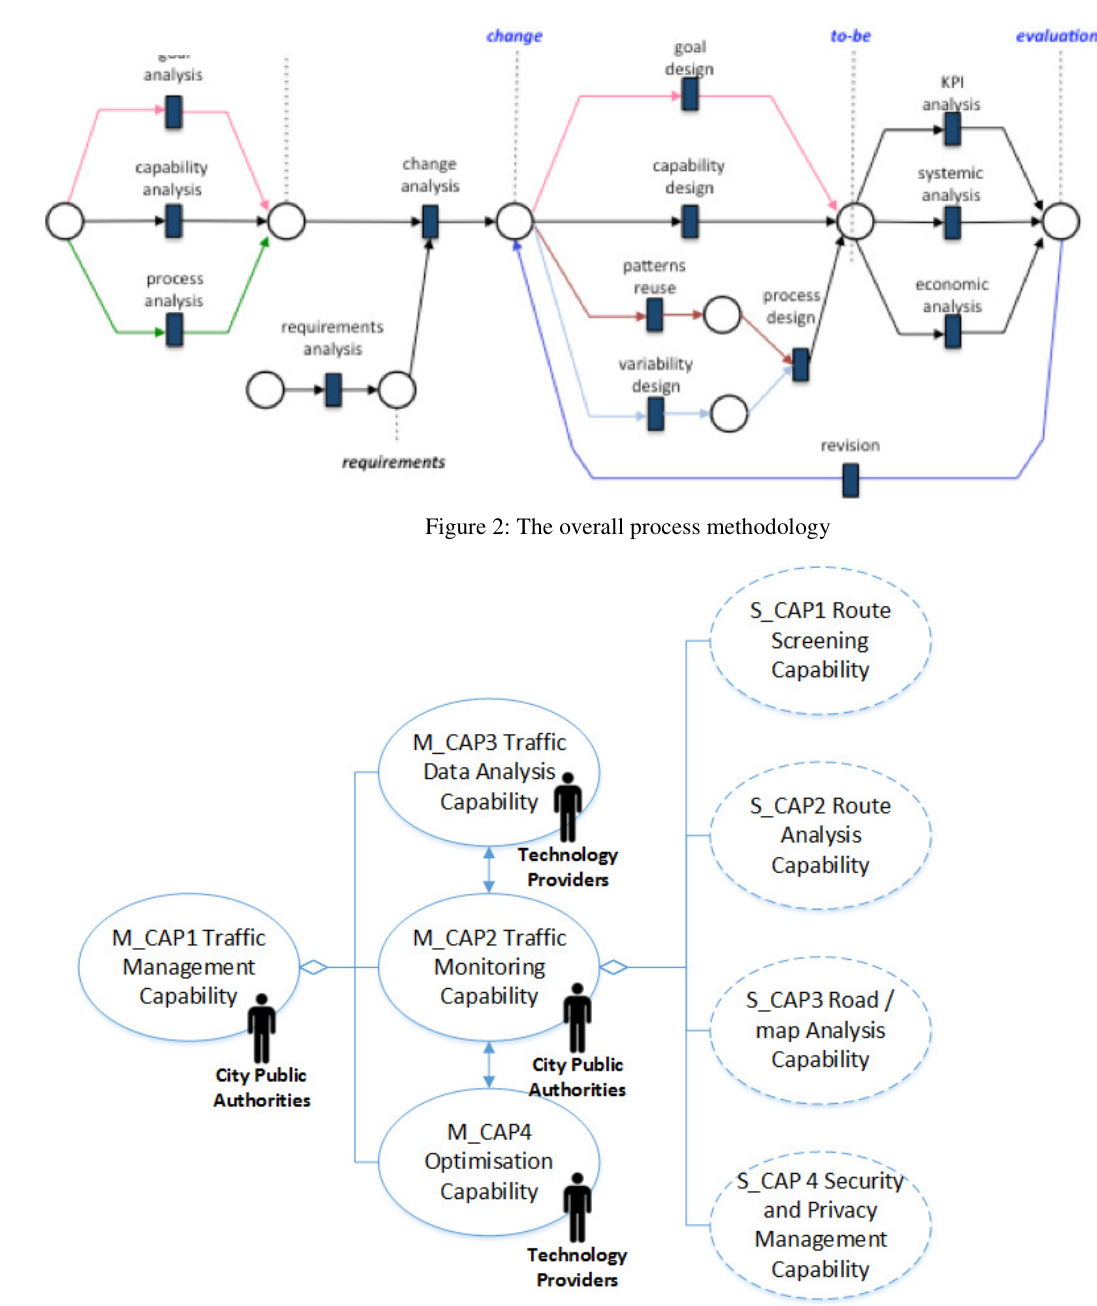
Figure 3 Main capability collaboration diagram